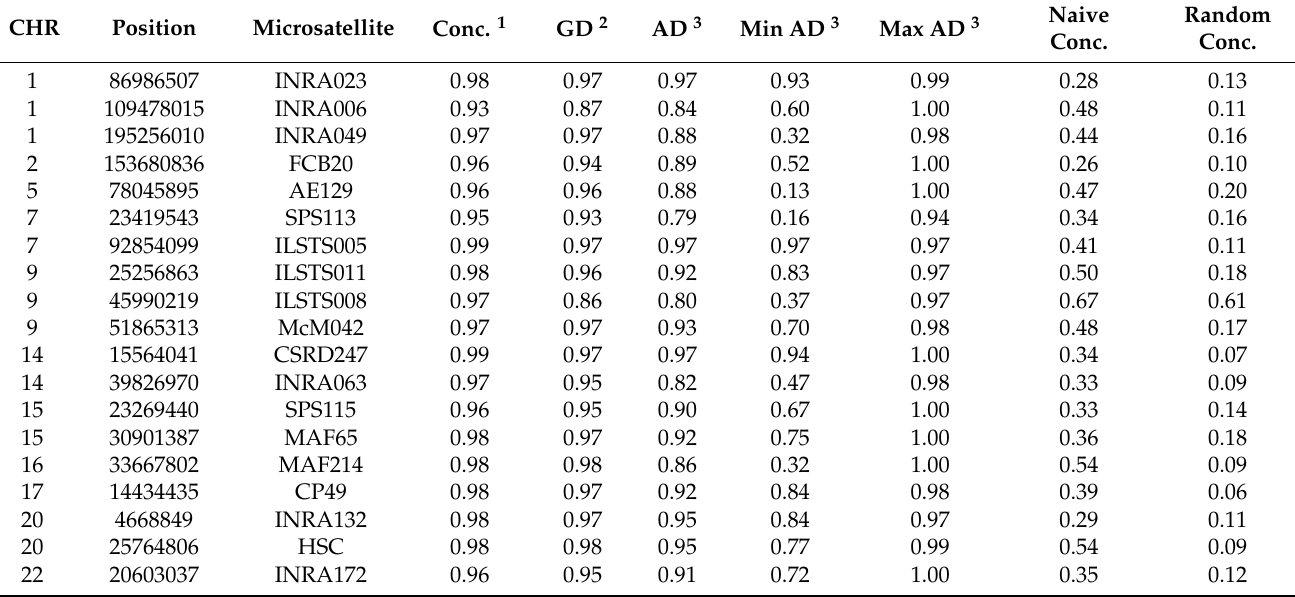
Table 2. Imputation performance metrics summary for the 19 microsatellites considered in this study using a 2-Mb window, together with the concordance obtained using the naive and random